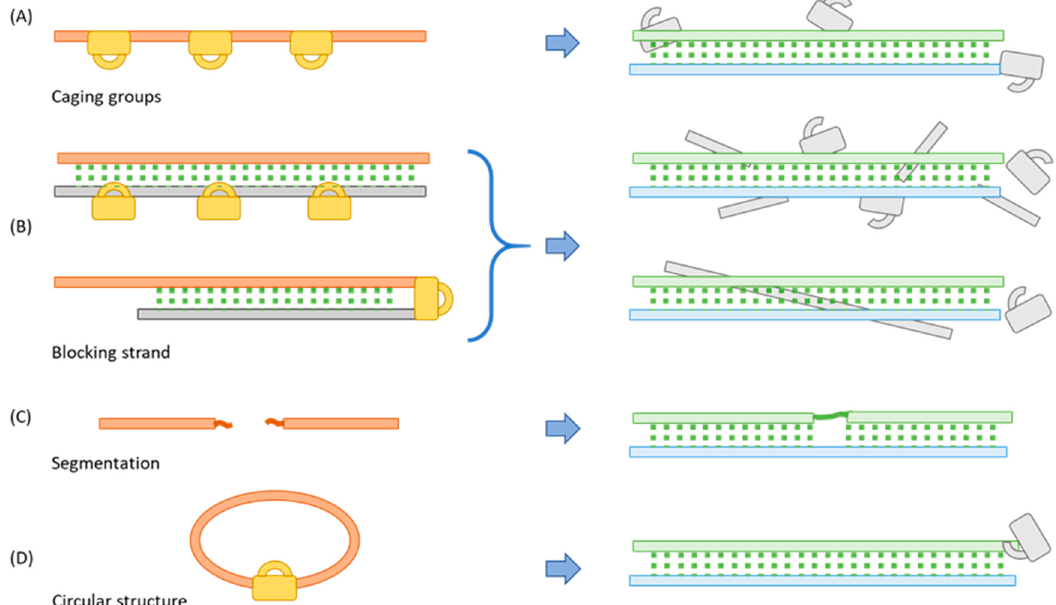
Figure 1. Four oligo caging strategies described in the literature: orange bars on the left illustrate the caged oligos while the green ones on the right are activated, and blue bars represent the target strands. ( A ) Incorporate bulky caging groups which are removed during activation; ( B ) Prehybridize with a complementary strand (the grey bar) that incorporates one or more cleavable linkers, which upon activation allows target binding; ( C ) Break the oligo into small segments and ligate the segments during activation; ( D ) Enforce a circular structure with a cleavable linker; activation linearizes the oligo, restoring its binding affinity.